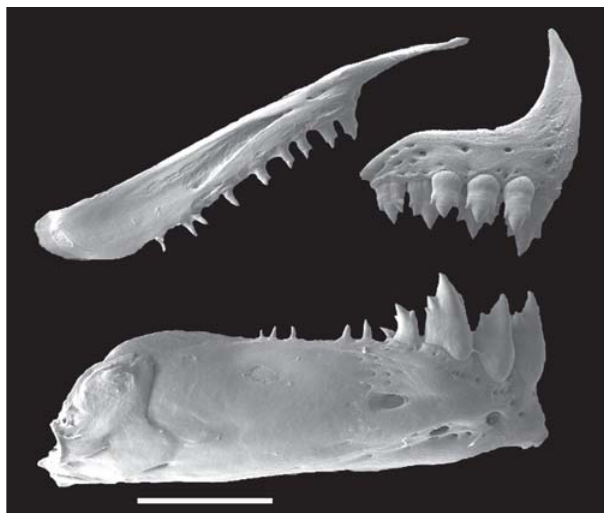
Fig. 11. Hemibrycon inambari , ANSP 143290, paratype, female, 39.2 mm SL. Scanning electron micrograph of right side upper and lower jaws. Scale bar = 1